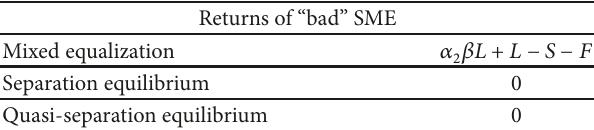
Table 9: Returns of “bad”